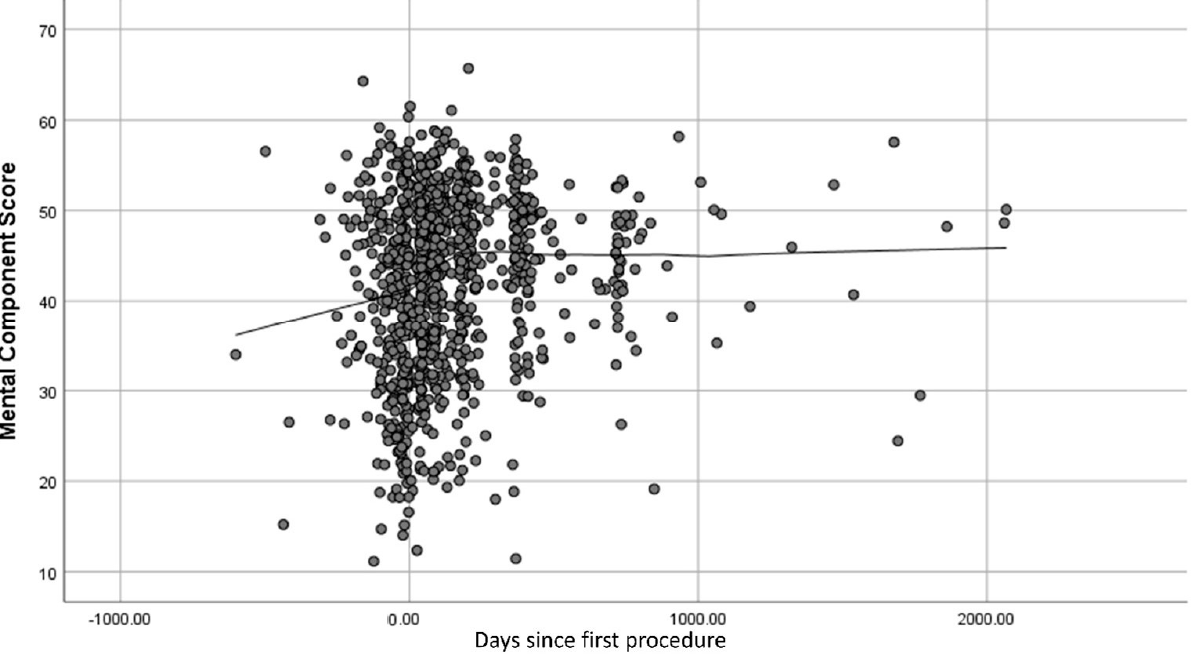
Figure 2. Scatter Plot of MCS Scores Over Time .